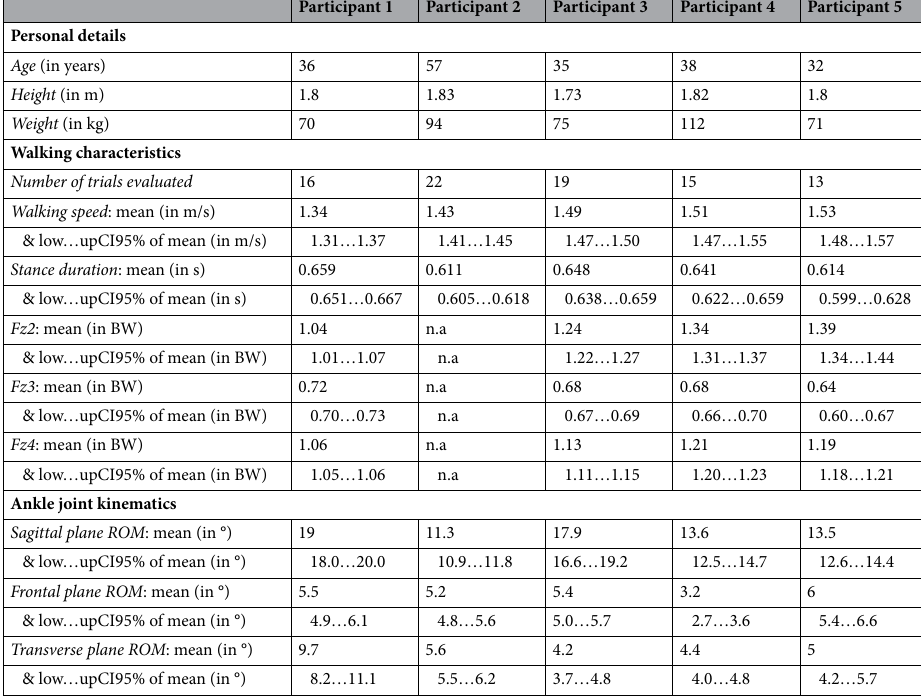
Table 1. Personal details of the Participant 1…5 and their walking characteristics. In addition to mean values, the corresponding lower and upper limit of the 95% confidence interval (low…upCI95% of mean) are reported. For definition of Fz2, Fz3, and Fz4, see Stacoff et al. 18 , all scaled to body weight